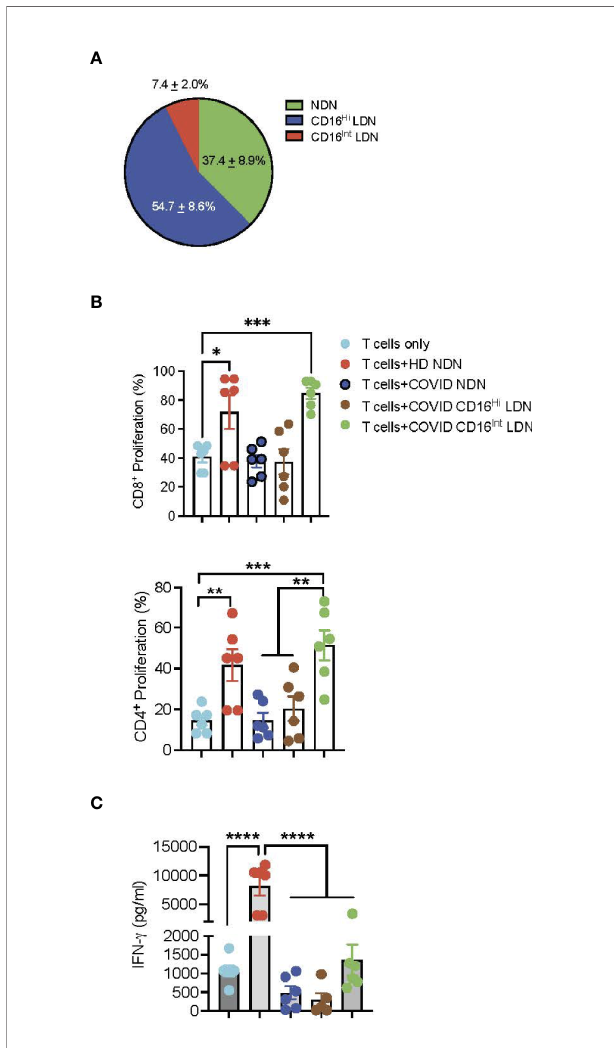
FIGURE 4 | T cell activation assay. (A) Pie chart showing the distribution of NDN, CD16 Hi and CD16 Int LDN from severe COVID-19 patients (n=12). (B) T cells from the same donor were surface labeled with CellTrace CFSE dye and then co-cultured with ND NDN, COVID NDN, CD16 Hi LDN, or CD16 Int LDN for 4 days in the presence of plate-bound anti-CD3. Cells were collected and stained with CD4 or CD8. T cell proliferation was determined by fl ow cytometry and is expressed as mean ± SEM percent proliferation (n=6). (C) Supernatants from those 6 experiments were harvested and the IFN- g level was determined by ELISA. Results are expressed as mean ± SEM in pg/ ml. *p < 0.05, **p < 0.01,***p < 0.001, ****p <